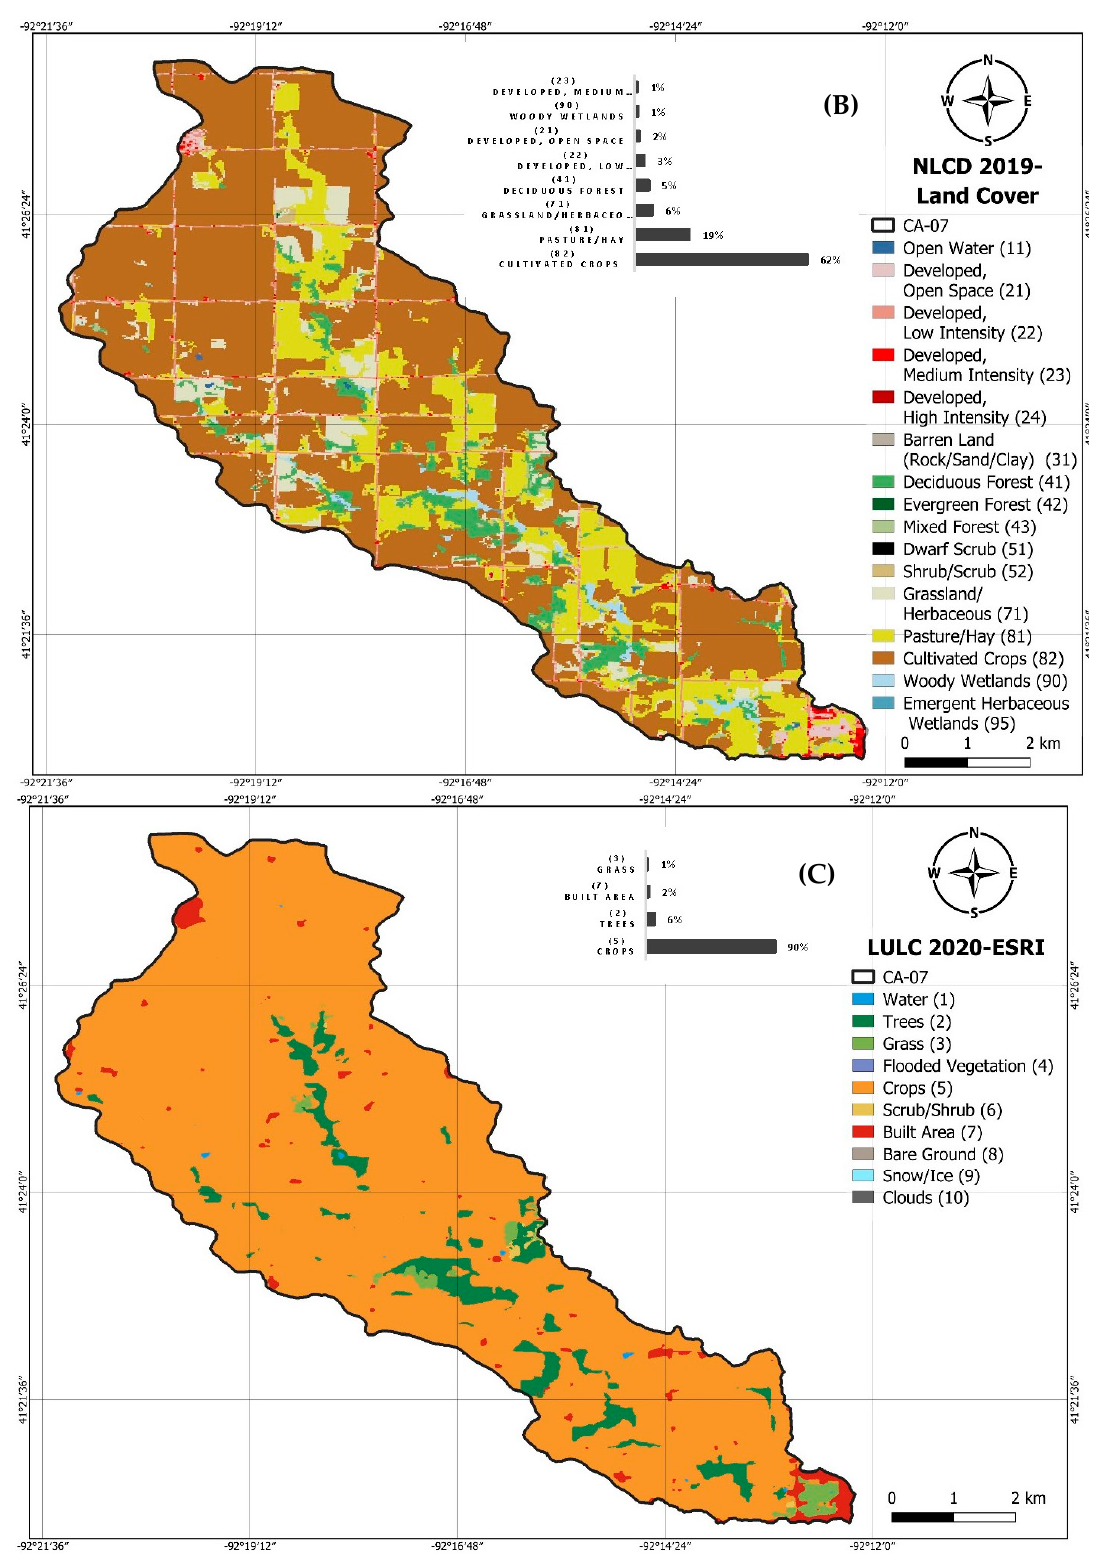
Figure A7. DEM and land-use maps for Catchment CA-07 ( A ) DEM, ( B ) NLCD 2019 land-use map, ( C ) LULC 2020-ESRI land-use map.